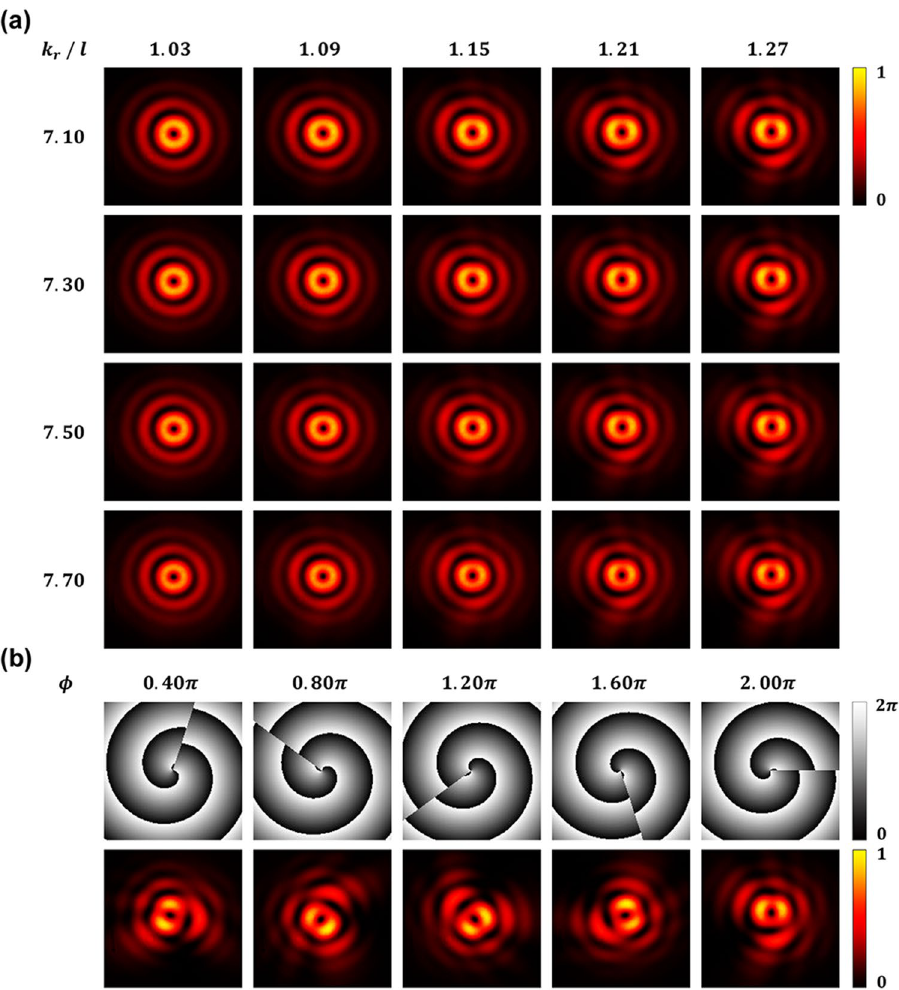
Figure 4. Experimental generation of fractional BG beams. ( a ) Some examples of the measured intensity profiles and ( b ) phase shift modulation of the fractional BG beam with k r = 7.10 and l = 1.45